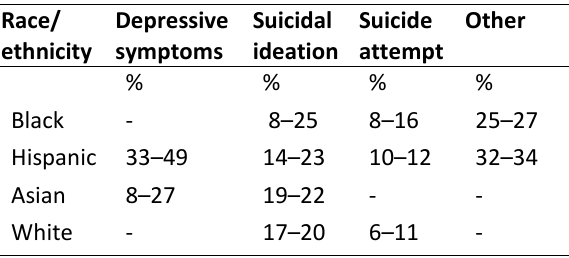
Table 2. Types of mental health outcomes for youth of color who are involved in offline and cyberbullying as bullies and/or